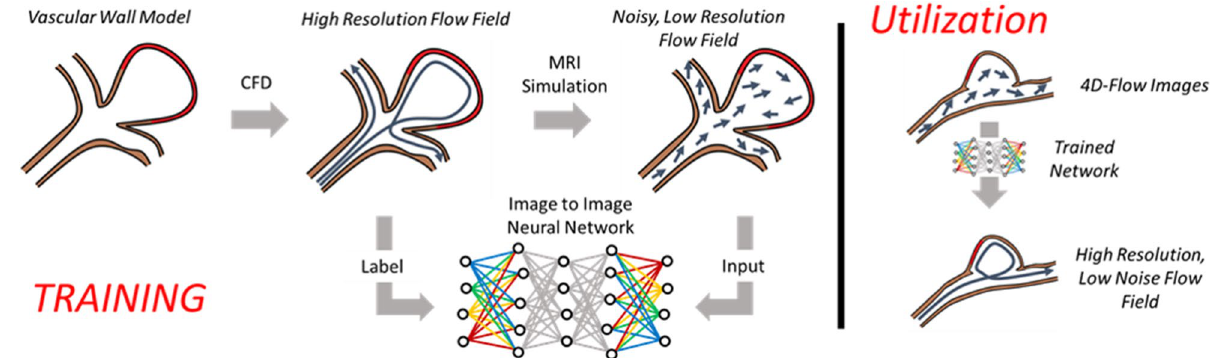
Figure 1. Method overview. Computational fluid dynamics (CFD) data was used to train a neural network. Network output was then applied to estimate high resolution, low noise flow fields from standard 4D flow MRI